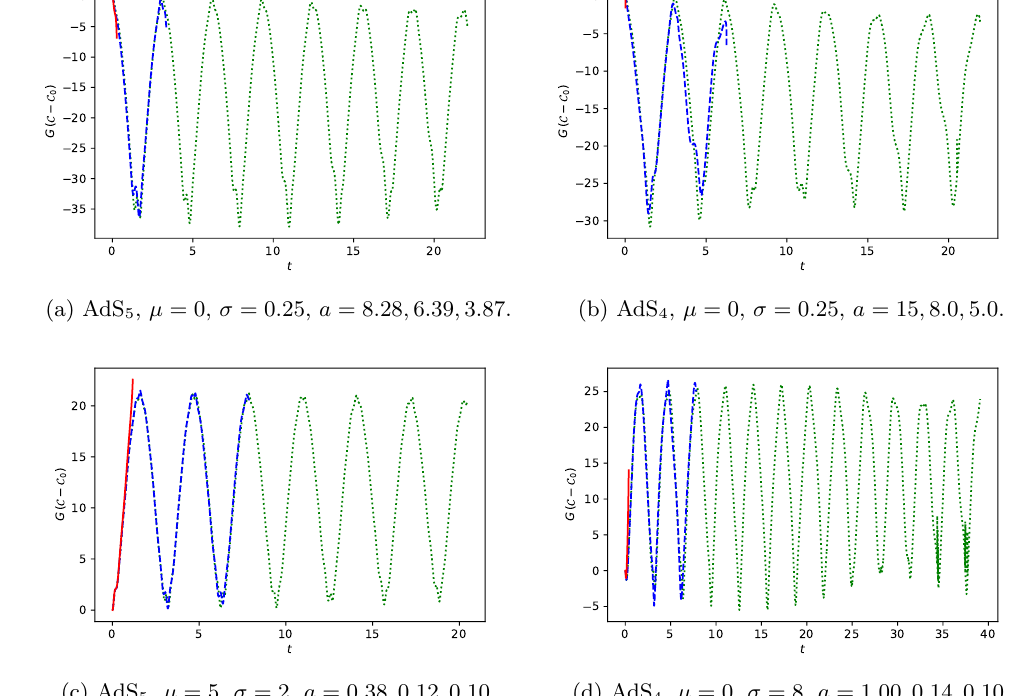
Figure 2. Volume complexity for listed initial data in AdS 4 and AdS 5 . Curve for the largest amplitude in each figure is solid red, middle is dashed blue, smallest is dotted